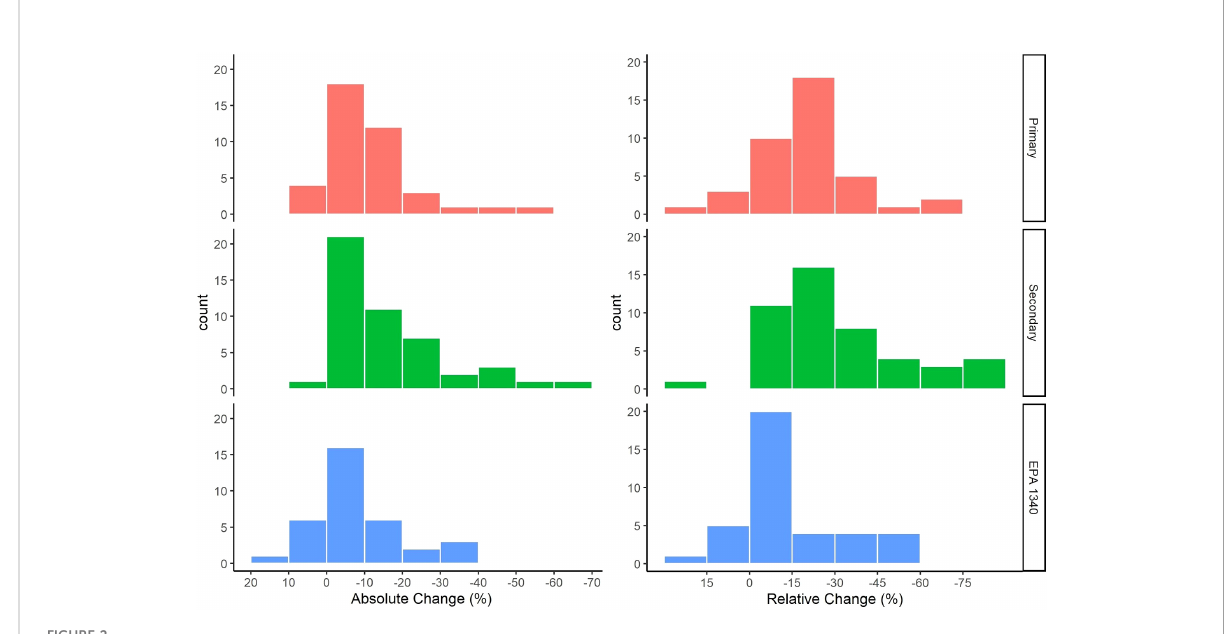
FIGURE 2 Distribution of relative change in IVBA Pb (%) for soils in each analysis group.